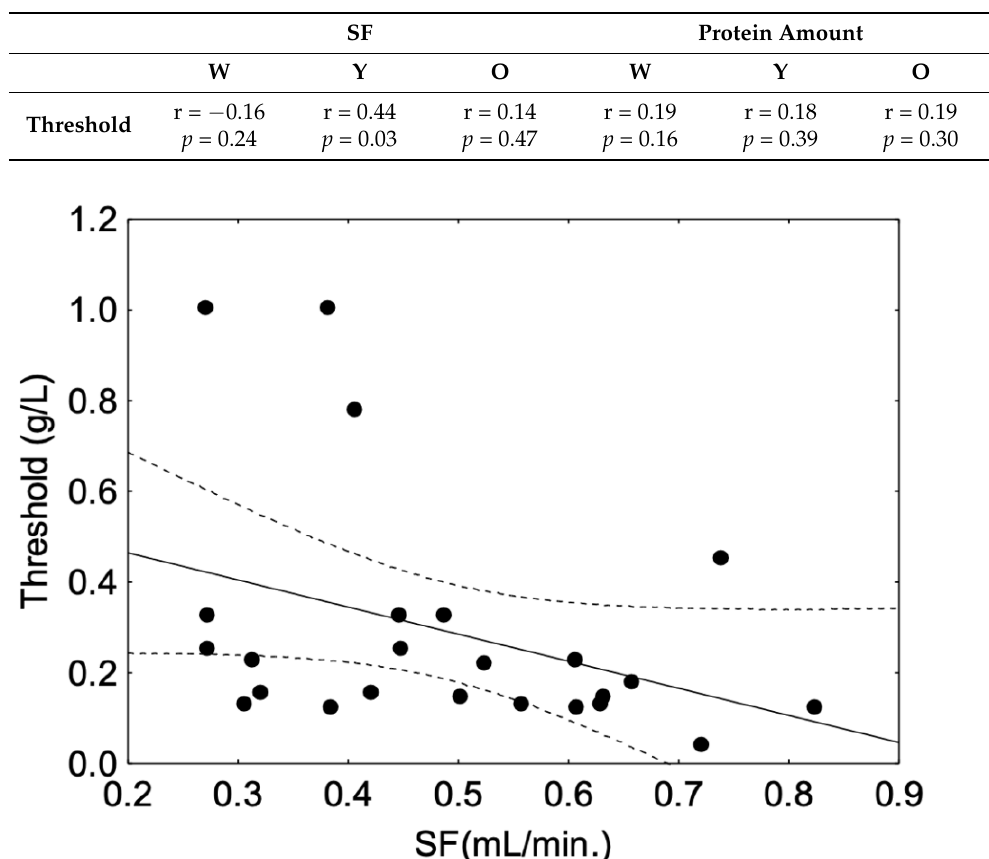
Table 2. Spearman correlation coefficient (r) and p value of the astringency threshold and salivary characteristics for the whole (W), young (Y) and elderly (O) panellists. SF: salivary flow.